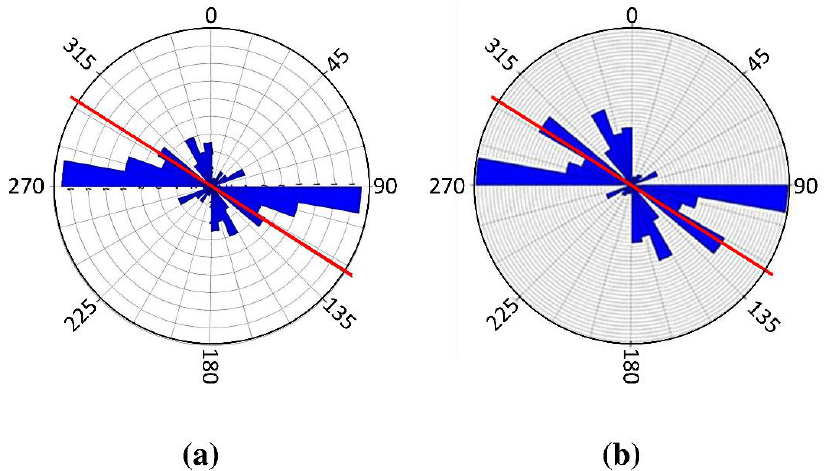
Figure 2. Rose diagrams showing the frequency ( a ) and length ( b ) of the stretch. The red line shows the main stress direction.